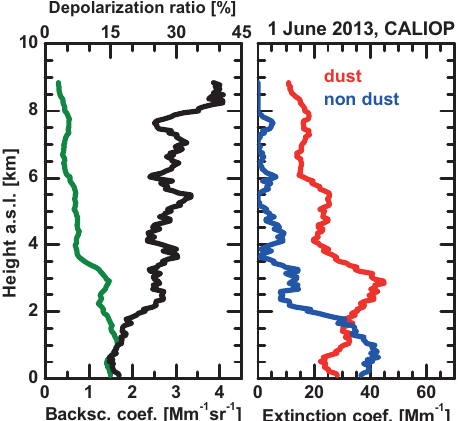
Figure 9. CALIOP data analysis products based on the 135 signal profile averages shown in Fig. 8: (Left) Vertical profiles of 532nm particle backscatter coefficient (green) and particle linear depolar- ization ratio (black), and (right) derived particle extinction coeffi- cients for non-dust (blue) and desert dust particles (red). The parti- cle backscatter coefficients (left, green) are taken from the CALIOP data base and smoothed with 600m gliding window length. The particle linear depolarization ratio is computed from the cross- polarized and total backscatter coefficient profiles after smoothing the profiles with 600m vertical window length. Lidar ratios used in the backscatter-to-extinction conversion are 50sr for the non-dust particles and 55sr for Saharan dust.